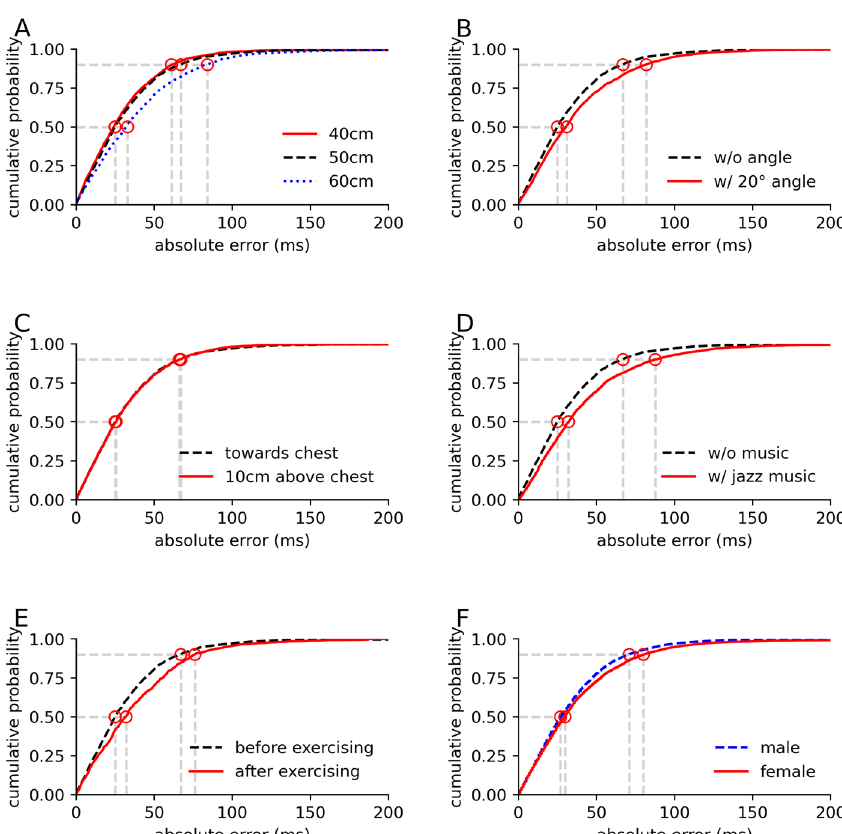
Fig. 4 Cumulative distribution functions (CDFs) of absolute error in R – R intervals in different sessions with healthy participants. A CDFs at different distances (red line, black dashed line, and blue dotted line represent 40, 50, and 60 cm, respectively) from the speaker, B CDFs with the speaker pointing left at a 20° angle (red line) from the chest, compared to right in front of the chest (black dashed line), C CDFs with the speaker pointing 10 cm above chest (red line), D CDFs with music playing in the background (red line), E CDFs after exercising in the last session (red line), and F CDFs across genders (red line and dashed blue line represent female and male,